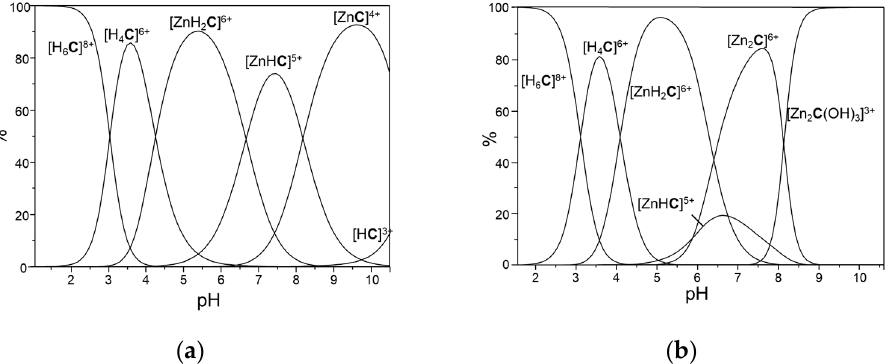
Figure 3. Distribution diagrams of the complexes formed by the [Ru(phen) 2 L ] 2+ (the [Ru(phen) 2 L ] unit is indicated with C for clarity); ( a ) [Ru(phen) 2 L ] 2+ /Zn II 1:1 molar ratio; ( b ) [Ru(phen) 2 L ] 2+ /Zn II 1:2 molar ratio ([Ru(phen) 2 L ] 2+ = 1 · 10 − 3 M).